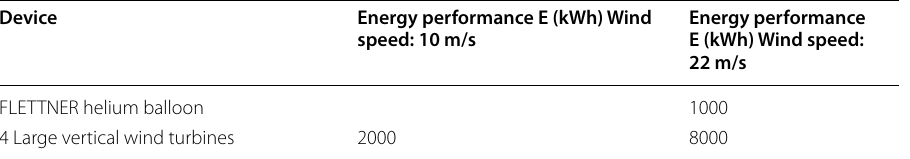
Table 3 Energy performance E (kWh) of electricity generator systems from unconventional